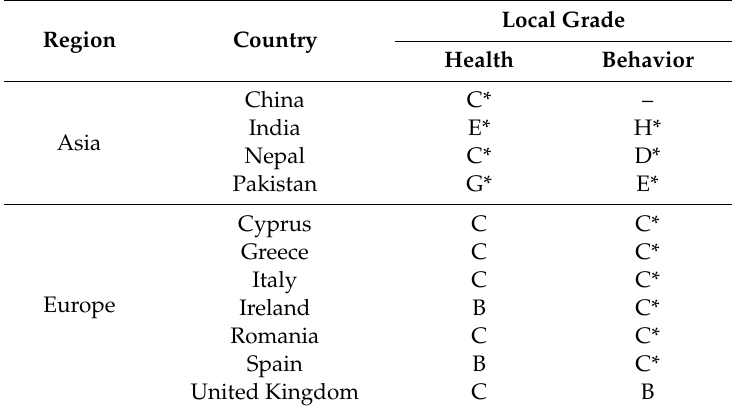
Table 5. Final grades obtained for each region for the welfare categories ‘behavior’ and ‘health’. Asterisks indicate that at least 15% of the animals in that region received a poor (red) assessment for one of the questions in the decision